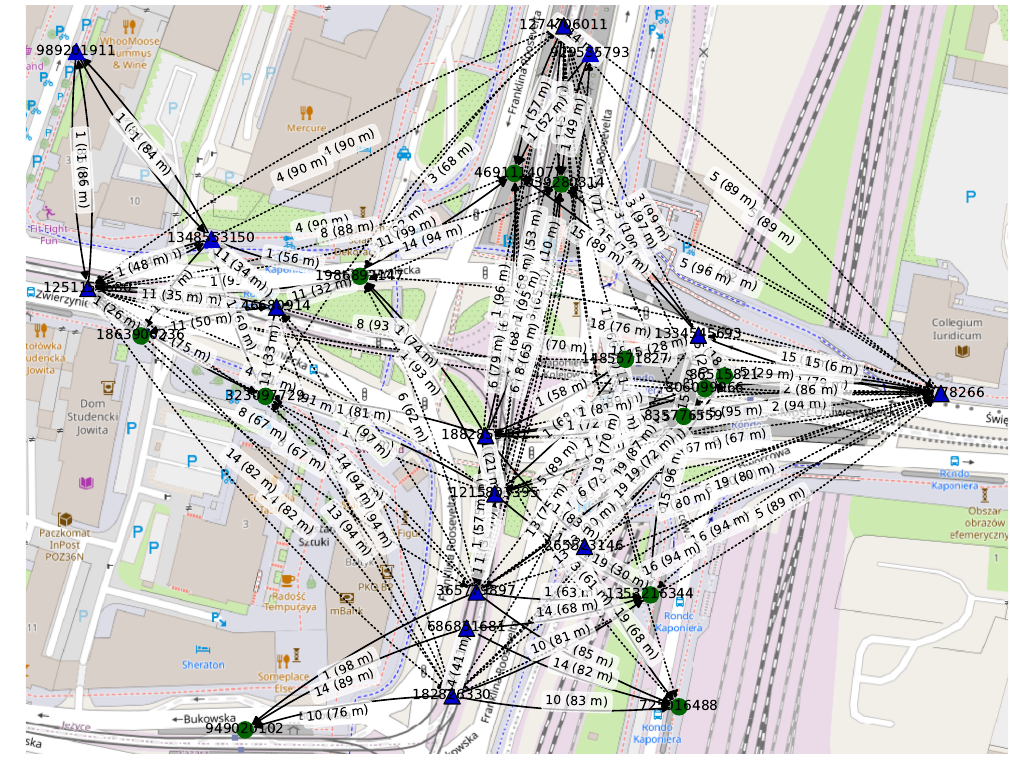
Figure 11. First-contact